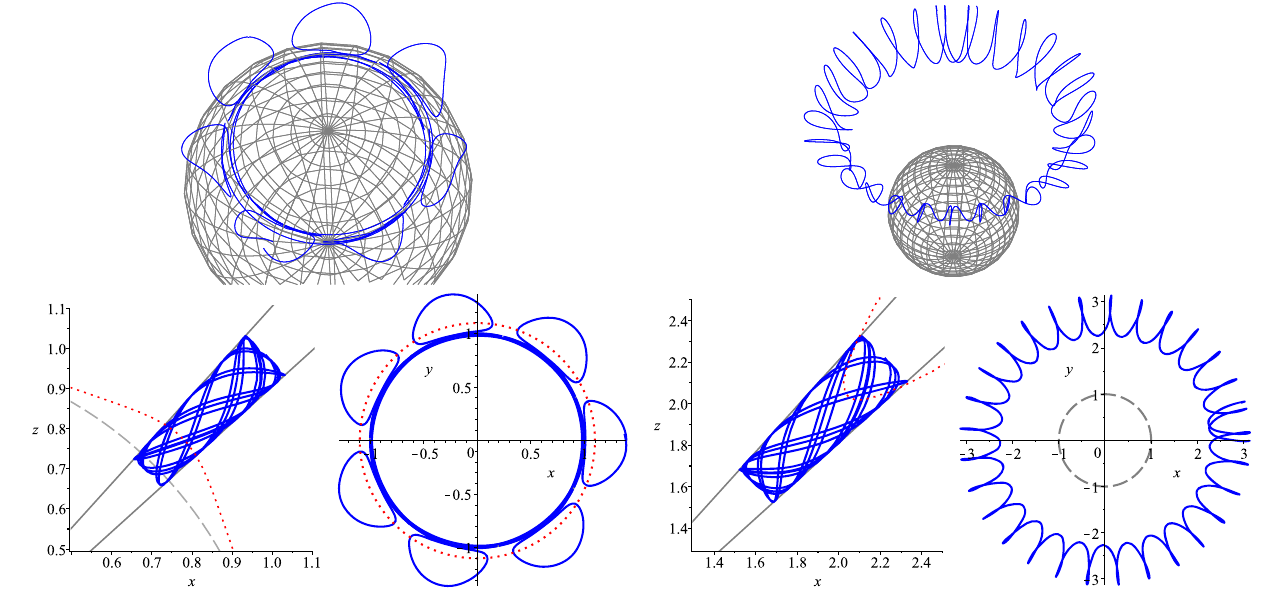
Fig. 6 MBO and BO for parameters K = 4 , L = 20 , δ = 1 , l = 1 , J = 0, and energy E = 0 . 95. The projections onto the x - z plane (bottom left) show the turning points of the φ motion as a dotted line.